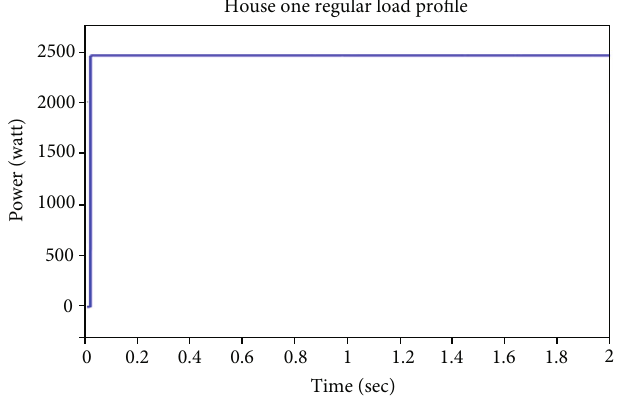
Figure 32: House one regular load pro fi le.